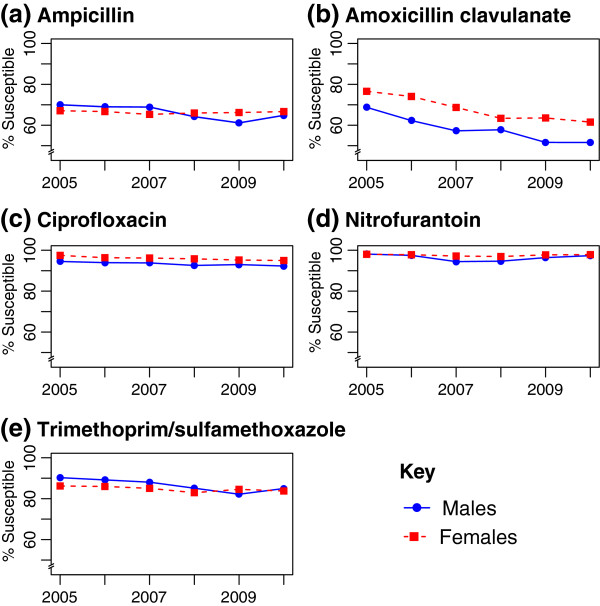
Susceptibility to urinary anti-Infectives by sex and year for E. coli cultured from urine. For all figures, males shown as blue solid line, females as red dashed line. a, ampicillin susceptibility (test for trend: males, p=0.058; females, p=0.6256); b, amoxicillin clavulanate susceptibility (test for trend: males, p=0.0006; females, p<0.0001); c, ciprofloxacin susceptibility (test for trend: males, p=0.1445; females, p<0.0001); d, nitrofurantoin susceptibility (test for trend: males, p=0.4967; females, p=0.5508); e, trimethoprim/sulfamethoxazole susceptibility (test for trend: males, p=0.0004; females, p<0.0001).